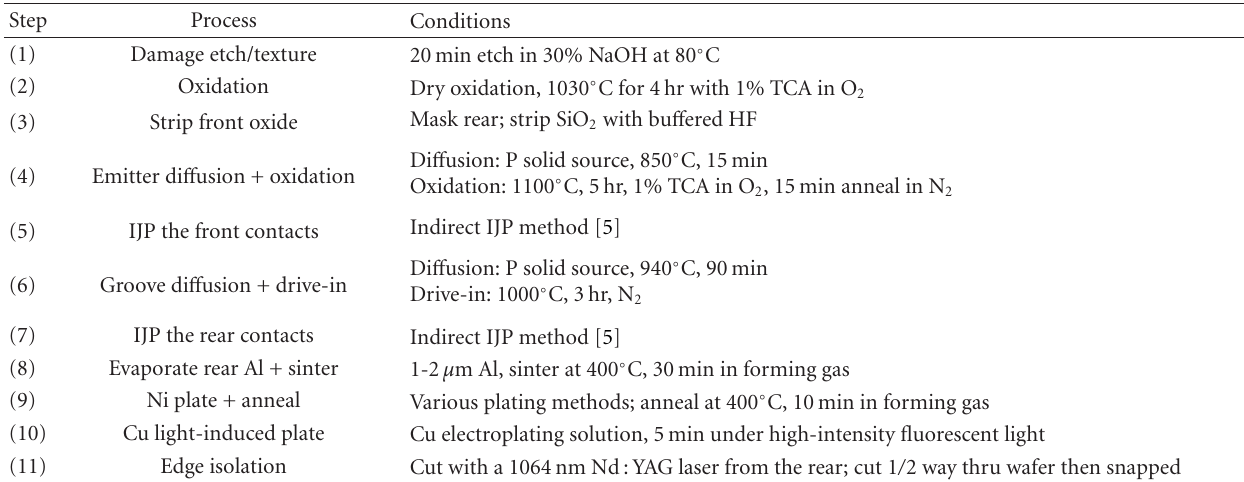
Figure 1: Experimental setup for (a) bias-assisted LIP; (b) noncontact LIP. Table 1: Processing sequence for IJP PERC cells.